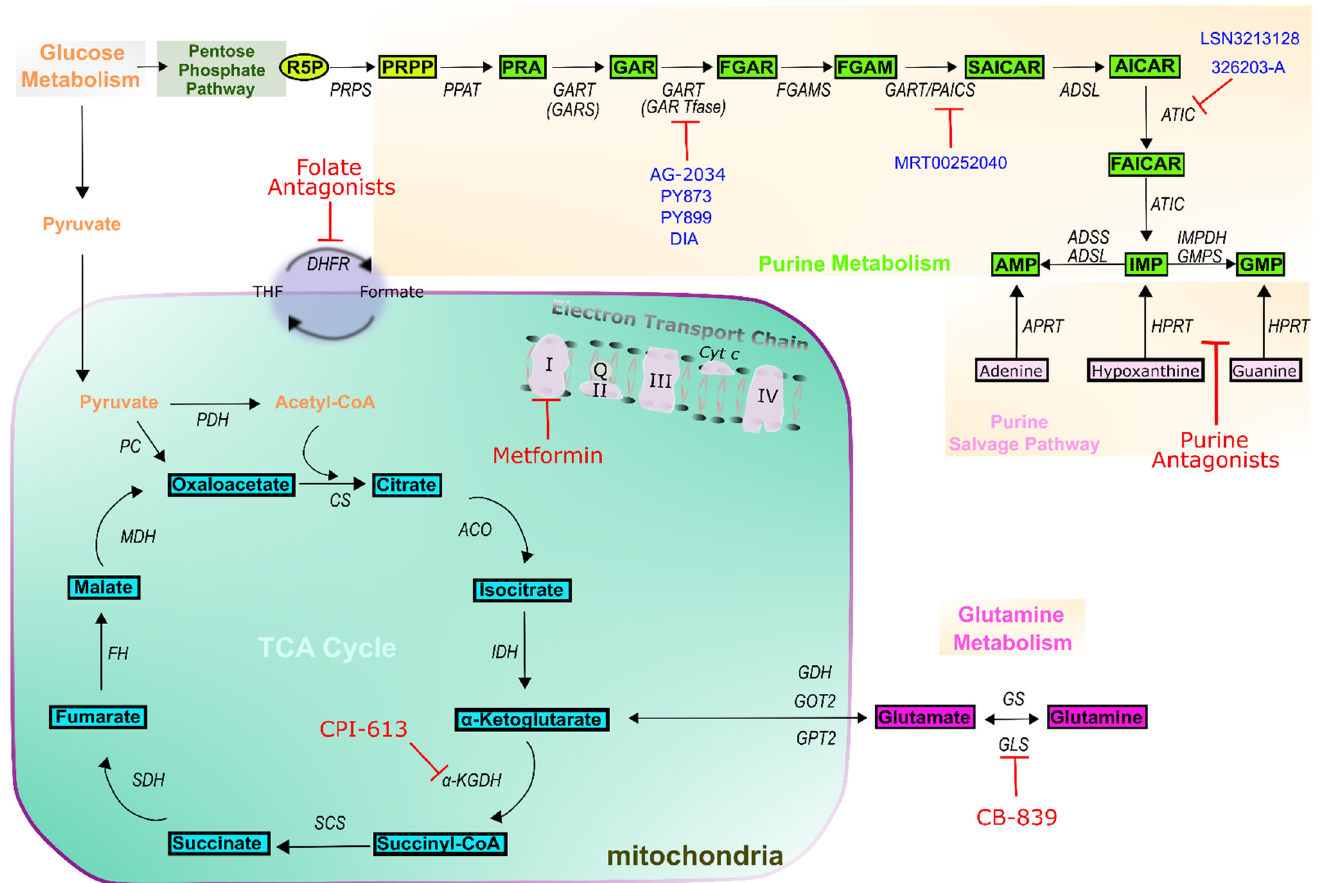
Figure 3. Targeted metabolic inhibitors. The schematic representation shows the metabolic vulnerabilities of cancer. The identification of rational combinations of mitochondrial inhibitors with the standard of care treatment including folate and purine antagonists may bring new insights for cancer treatment. FDA-approved drugs to treat cancer are indicated in red, and drugs under study or in clinical trials are indicated in blue. The identification of novel biomarkers and drug targets to improve the detection and treatment of cancers by modulating purine metabolism is now subject to investigation in several research programs.